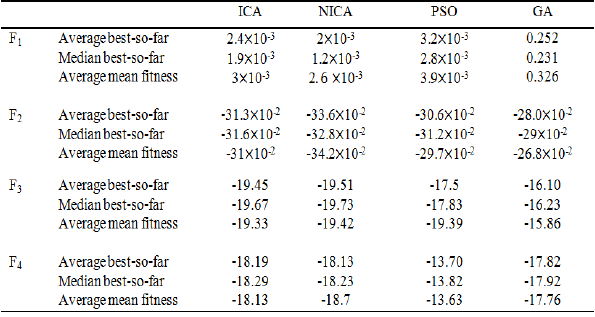
Figure 4; NICA wants to find the global optimum faster than others and hence has a higher convergence rate.